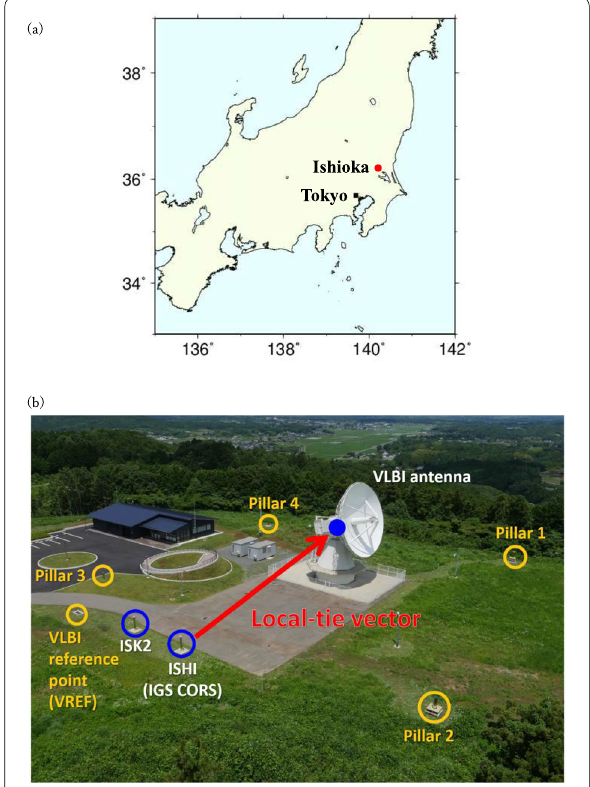
Fig. 1 Location and the panoramic view of the Ishioka station. a Location map; b panoramic